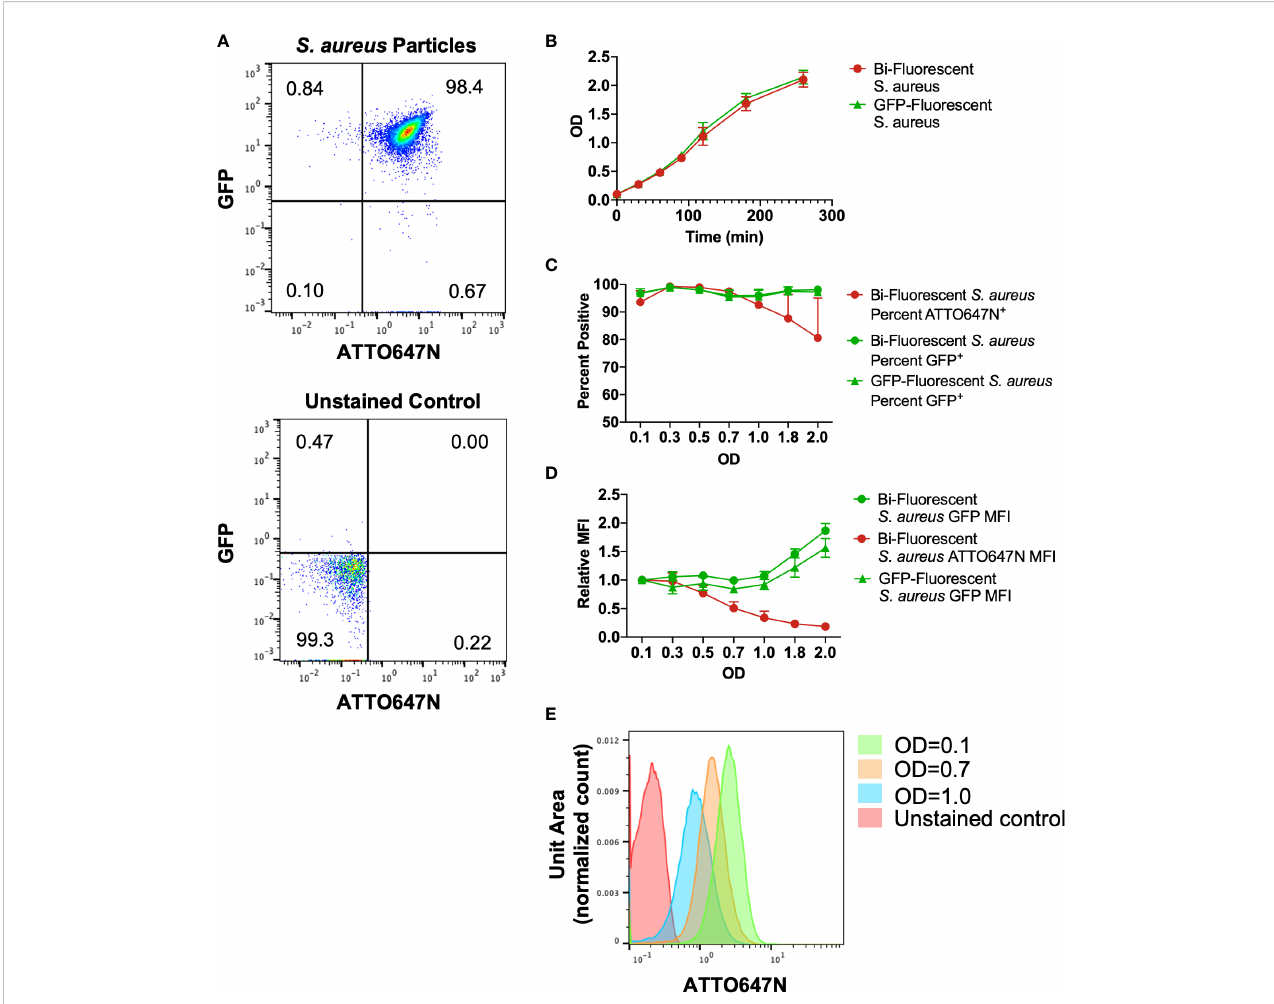
FIGURE 1 Characterization of cultured bi- fl uorescent S. aureus . (A) Staining GFP- S. aureus with 200ng/mL ATTO647N-NHS Ester generates a pure population of bi- fl uorescent S. aureus detectable by fl ow cytometry. (B) The growth curve of S. aureus with or without secondary ATTO647N-NHS Ester stain was indistinguishable. (C) The percent of particles gated as GFP + or ATTO647N + relative to unstained control demonstrates a loss of detection of the ATTO647N signal with bacterial replication. (D) Geometric mean fl uorescent intensity (MFI) of GFP or ATTO647N signal relative to the signal at the start of growth in culture demonstrates robust GFP MFI and loss of ATTO647N signal with bacterial replication (n=3, performed across three independent experiments). (E) Representative shifts in the ATTO647N fl uorescent intensity towards the unstained control with increasing OD, with overlap visualized at